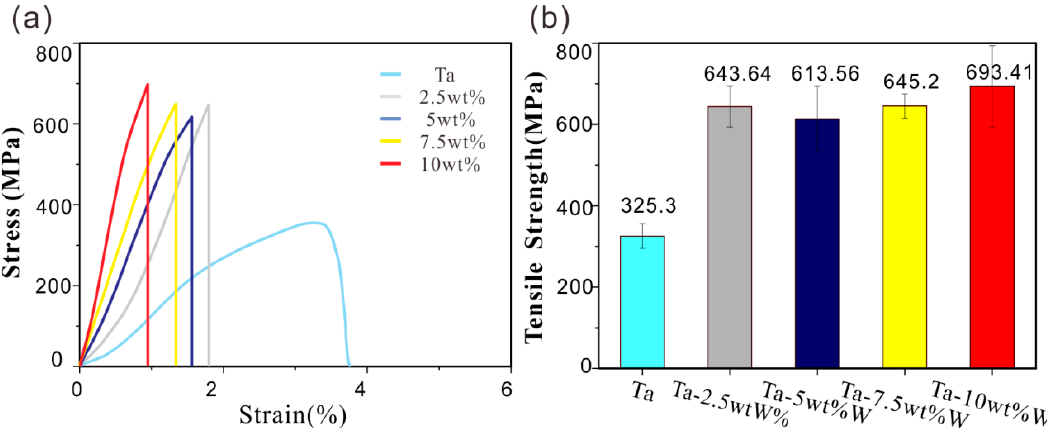
Figure 6. Tensile test ( a ) stress-strain curves of Ta-W alloy, ( b ) tensile strength of Ta-W alloy.